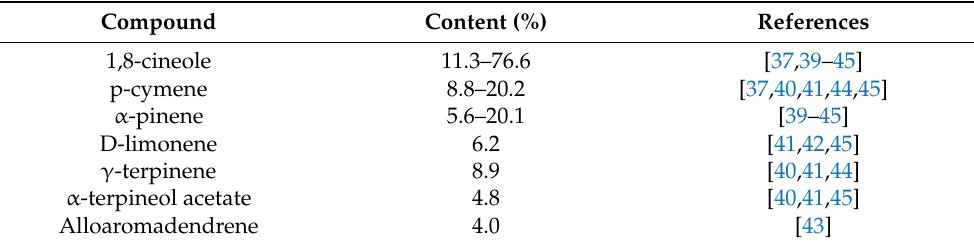
Table 2. The main compounds of E. globulus essential